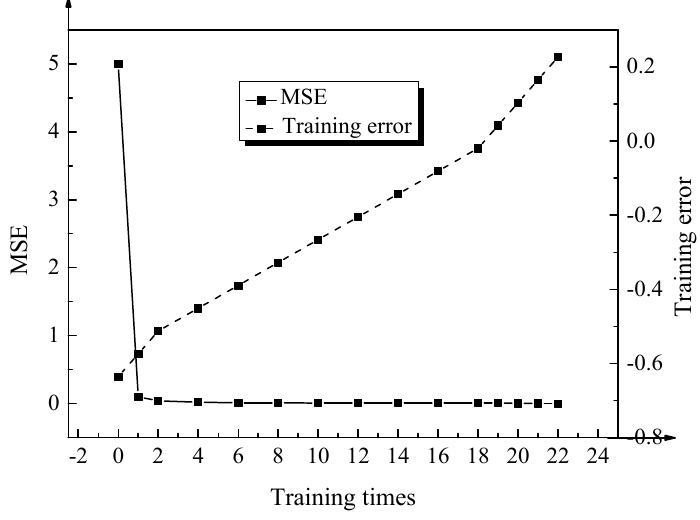
Figure 5. Training results of the land use evaluation model .